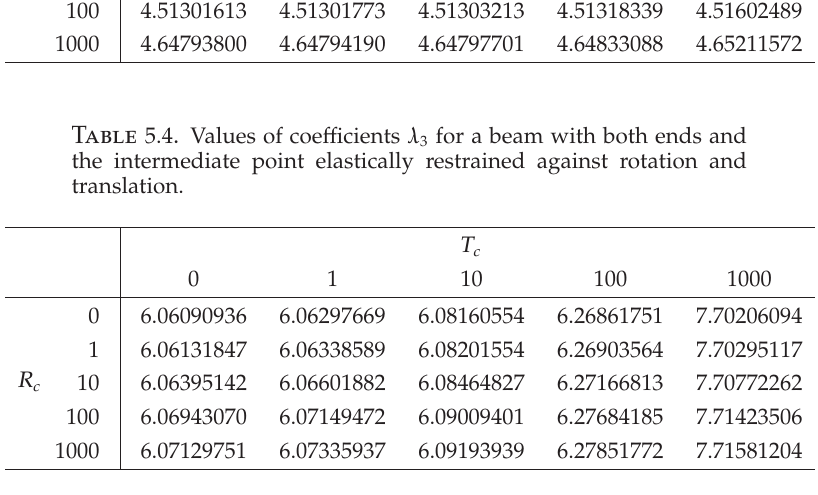
4 for a beam with both ends and